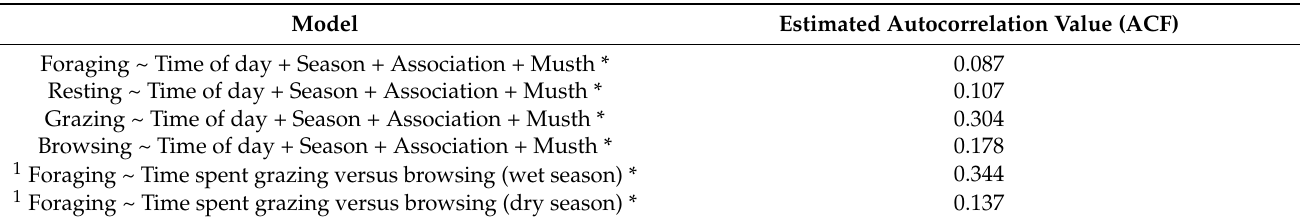
Table 3. Autocorrelation values used in each generalized mixed effect model, to correct for autocorrelation of measurements due to the effect of possible individual foraging preferences between elephants. Response variables indicate the percentage of time spent grazing/browsing/foraging or resting during observations. * Indicates that the model produced predicted a significant effect of at least one predictor variable.